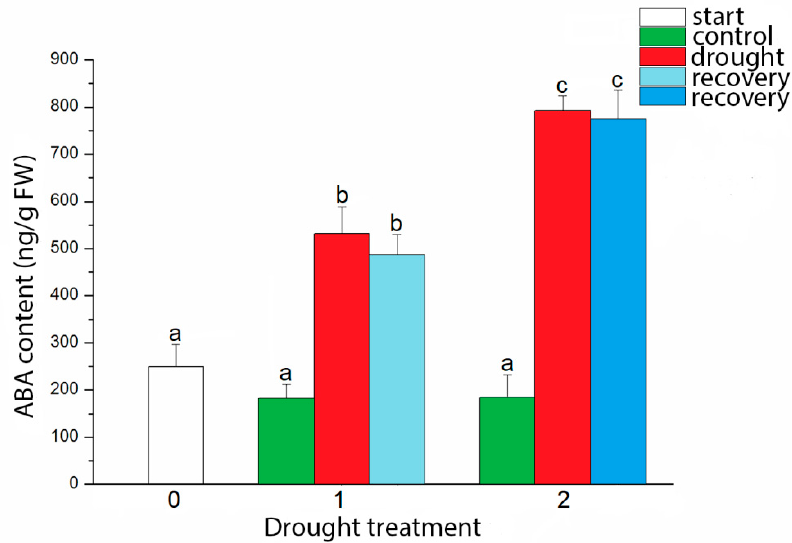
Figure 4. Effect of drought on abscisic acid (ABA) content in I. walleriana grown ex vitro. The “start point”, 15% and 5% of soil moisture content—0, 1 and 2, respectively; results represent mean ± SE ( n = 8). The letters indicate statistically significant differences based on the Fischer LSD test ( p ≤ 0.05).